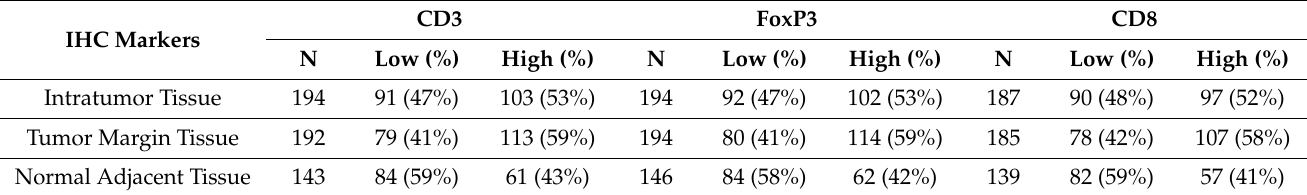
Table 2. Distribution of cases according to the expression of CD3, FoxP3 and CD8 markers.